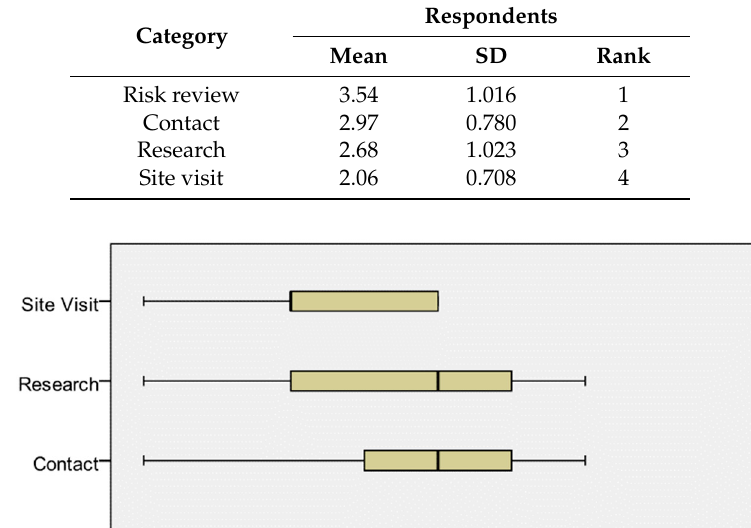
Table 4. How risks are identified by the companies.